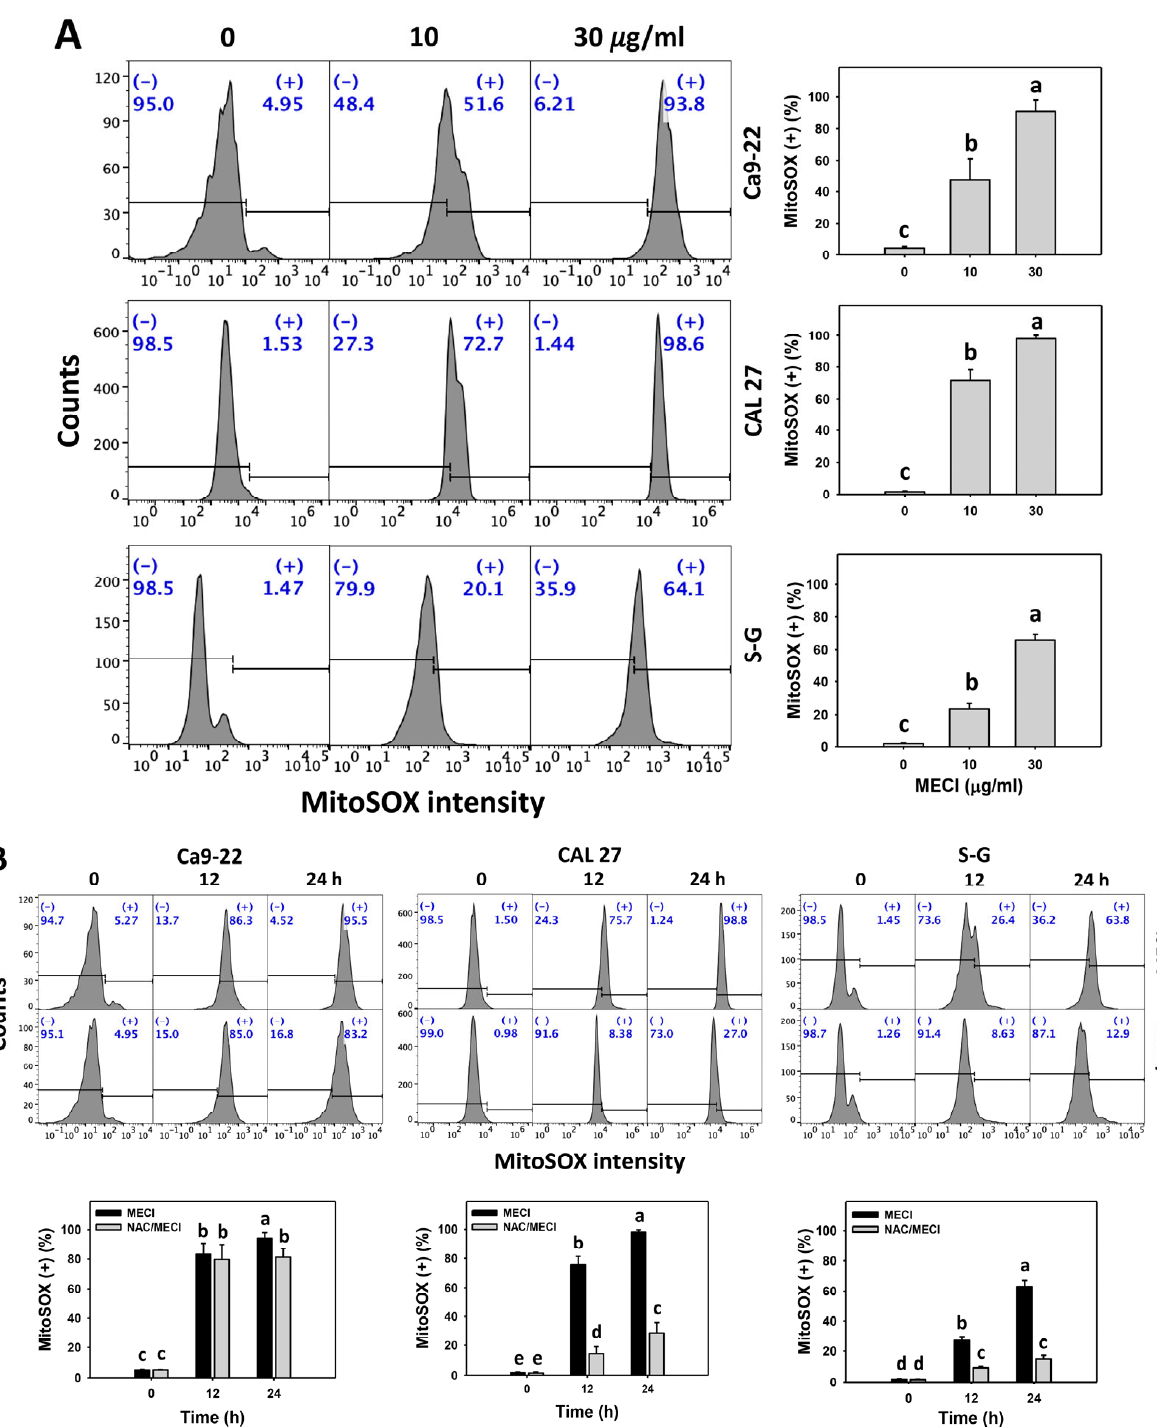
Figure 7. MitoSOX assay. ( A ) MitoSOX change. Except for S-G cells, other cells were oral cancer cells. After 24 h MECI incubation (0 (0.1% DMSO in the medium), 10, and 30 µ g/mL), cells were subjected to a MitoSOX assay. (+) spots were specified for MitoSOX (+). ( B ) Impact of NAC on MECI-induced MitoSOX change to oral cancer cells. After pretreatment with NAC, cells were post-treated with MECI (30 µ g/mL) for 0, 12, and 24 h. Data, mean ± SD ( n = 3). For the same cell line, columns showing non-overlapping letters differ significantly ( p < 0.05).